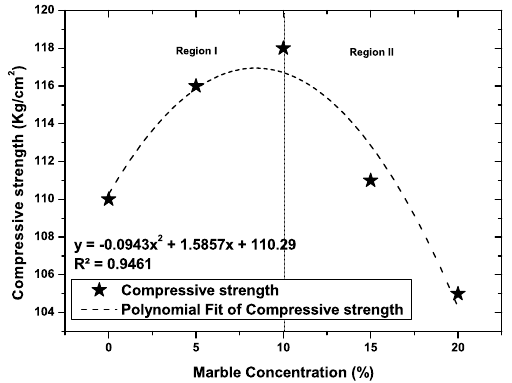
Figure 3: Compressive strength and marble concentra- tion.